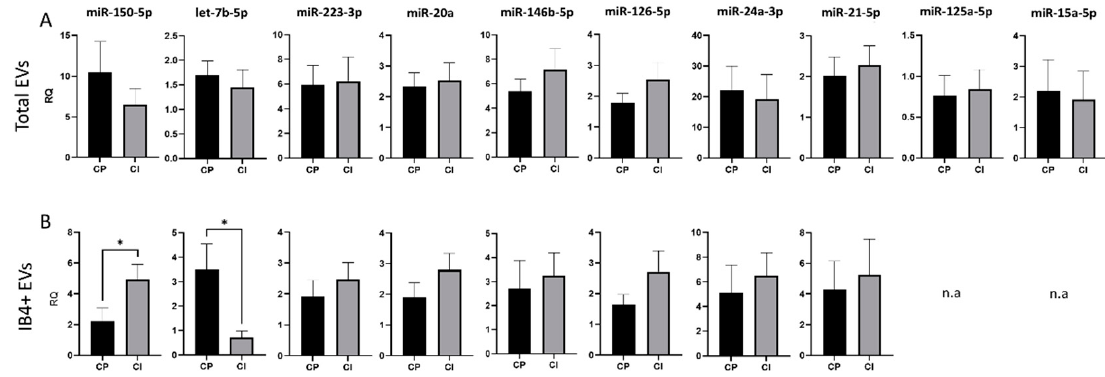
Figure 3. miRNA cargo in total and IB4-positive (IB4+) EVs in the Italian cohort of MS patients. ( A ) RQ of selected miRNA levels in total plasma EVs from CP and CI patients. ( B ) RQ of selected miRNA levels in IB4+ EVs from CP and CI patients. Data were normalized to miR-16-5p and miR-21-5p, expressed as 2 – ∆∆ Ct . Mann–Whitney test, * p < 0.05, ** p < 0.001.